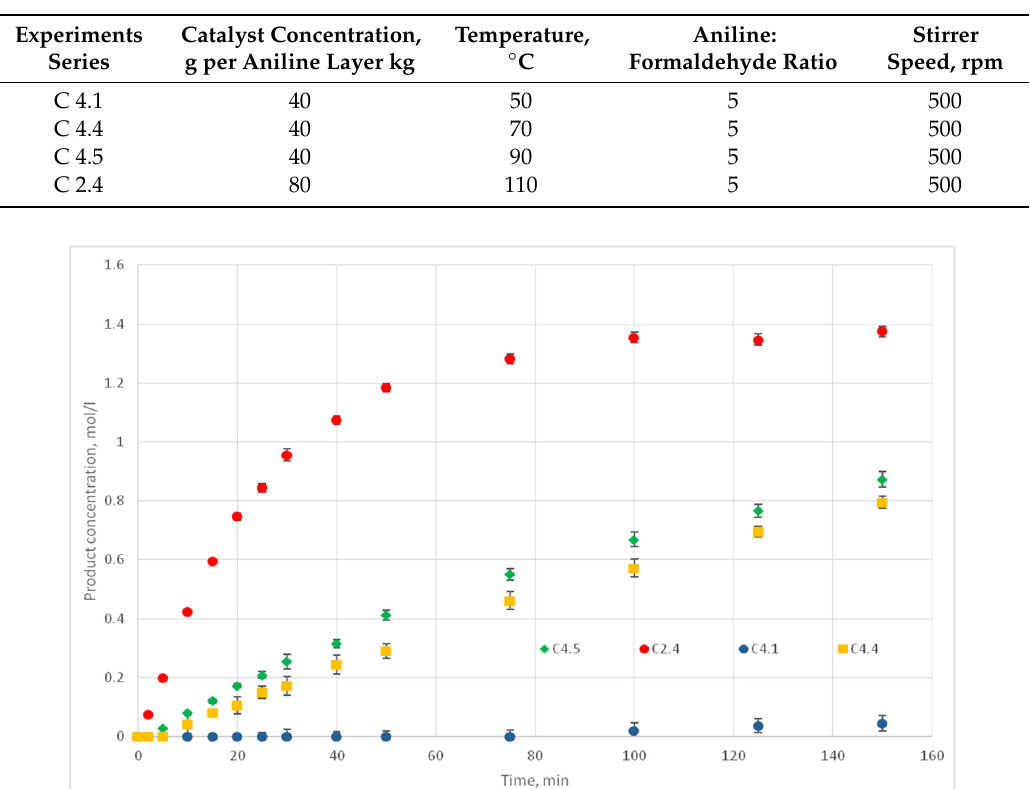
Figure 17. Experimental kinetic curves for C2.4, C4.1, C4.4 и C4.5 experiments.